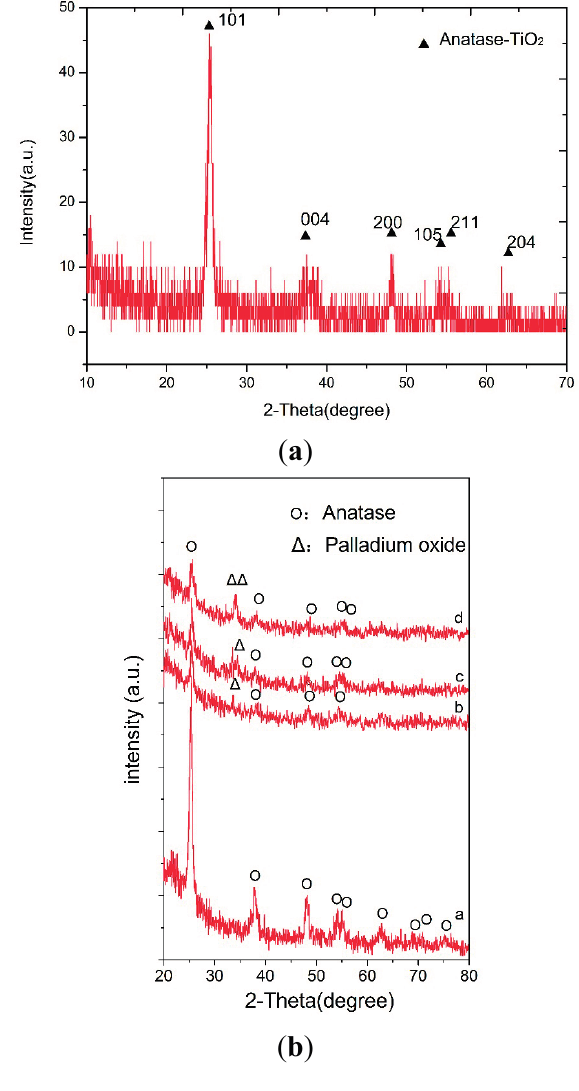
Figure 5. X-ray diffraction analysis (XRD) patterns. ( a ) XRD pattern of the pure TiO ( b ) XRD pattern of TiO annealed at 500 °C with different Pd sputtering times: a = 0.0, b = 5 s, 2 c = 10.0 s, d = 20 s, reproduced with permission from